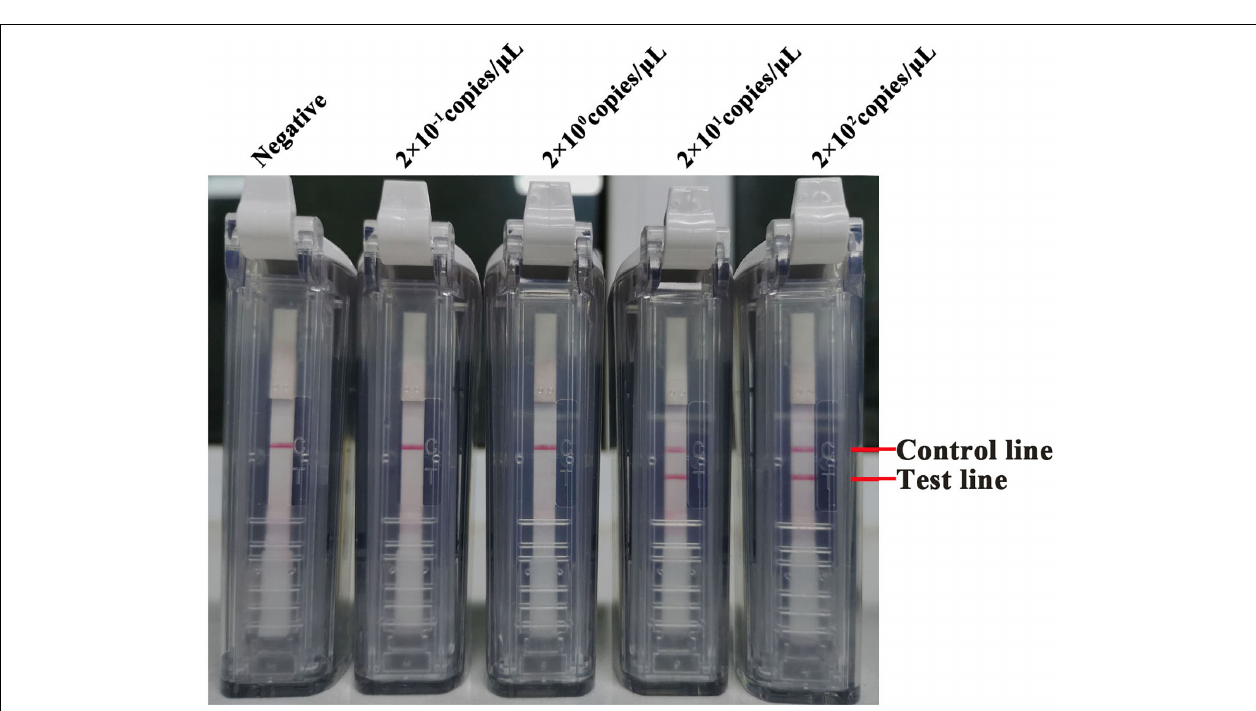
FIGURE 3 | The specificity of the RT-LAMP-VF assay has been examined through the respiratory pathogens. Nucleic acids from a variety of human coronaviruses and other respiratory pathogens were detected by the RT-LAMP-VF assay.